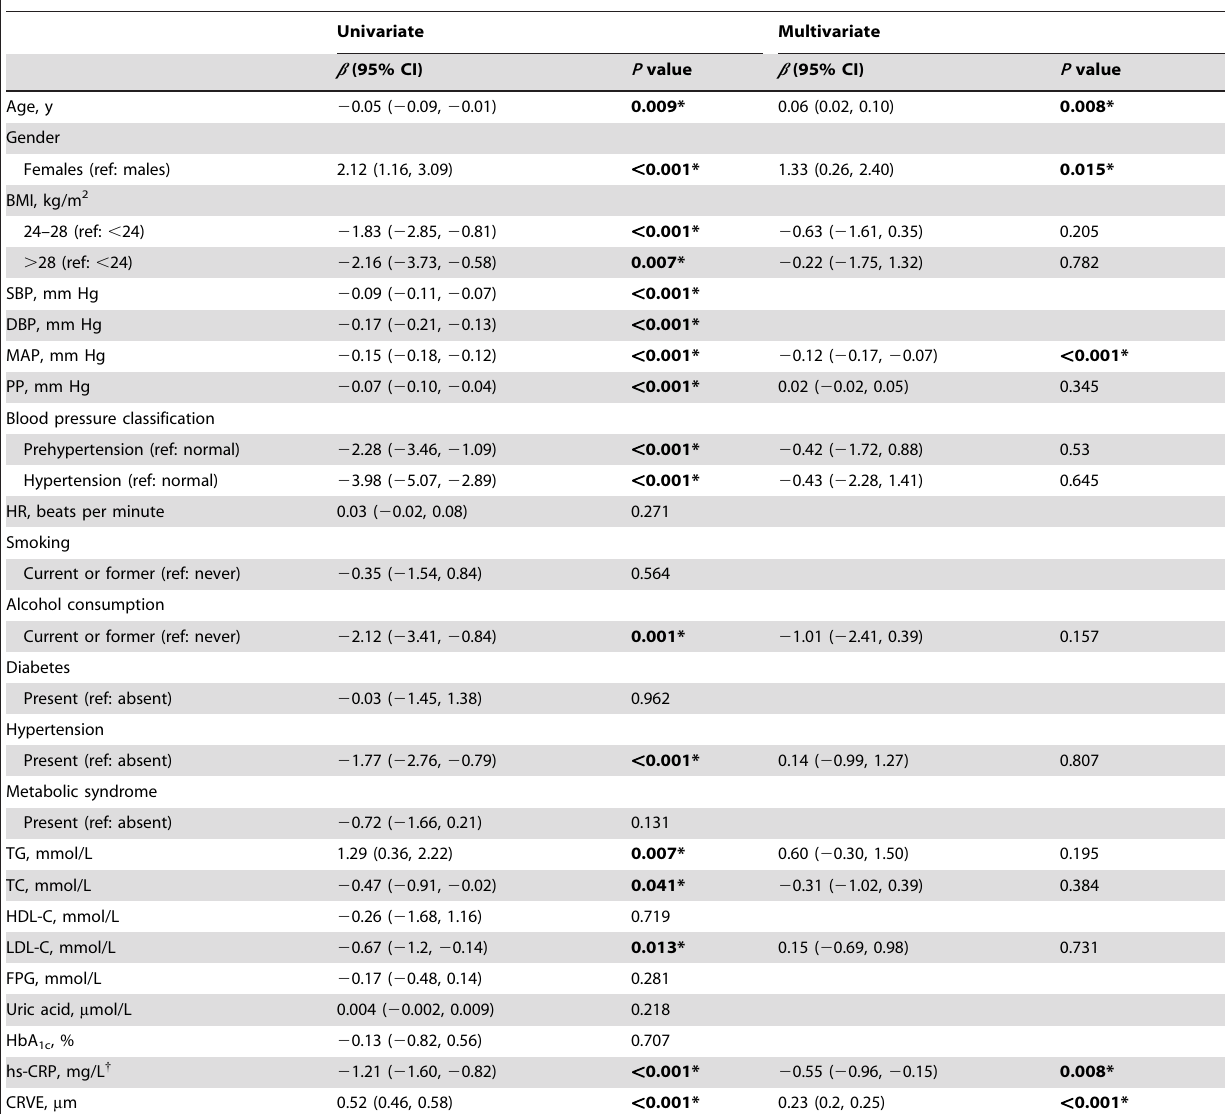
Table 3. Simple and multiple linear regression analyses for